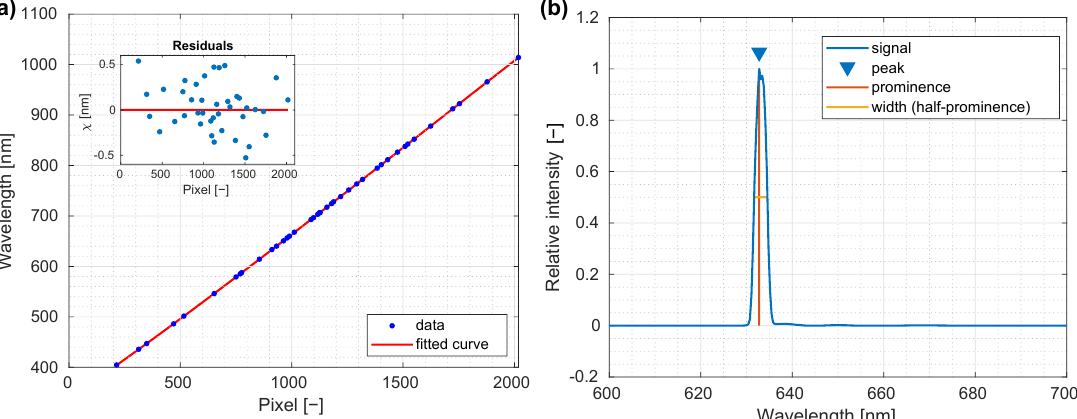
Figure 4. Spectral characterization of a custom-made laboratory hyperspectral imaging (HSI) system. ( a ) Fitting of 40 different gas spectral lines to determine the corresponding detector pixel index. ( b ) An averaged spectrum of a He–Ne laser along with the determined full width at half maximum (FWHM) (2.9 nm). Note the asymmetry of the laser line, which is due to the broadening of the